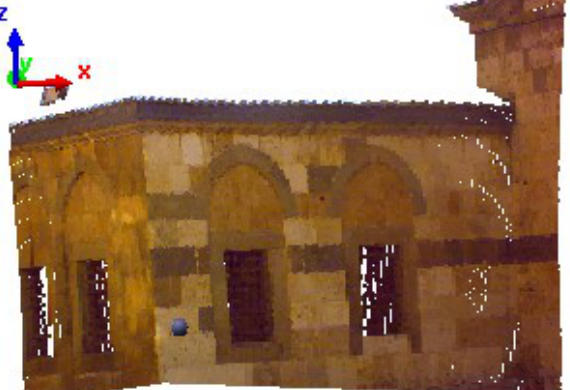
Figure 4. TLS point cloud data of building